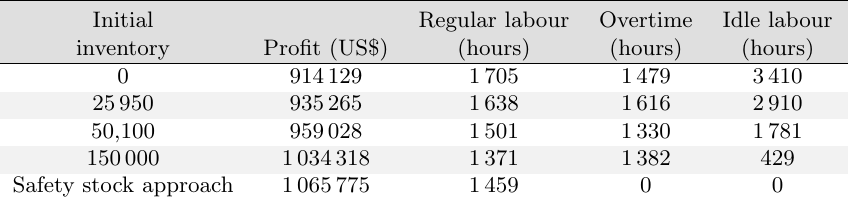
Table 4: Comparison of the effect of beginning inventory on profit and